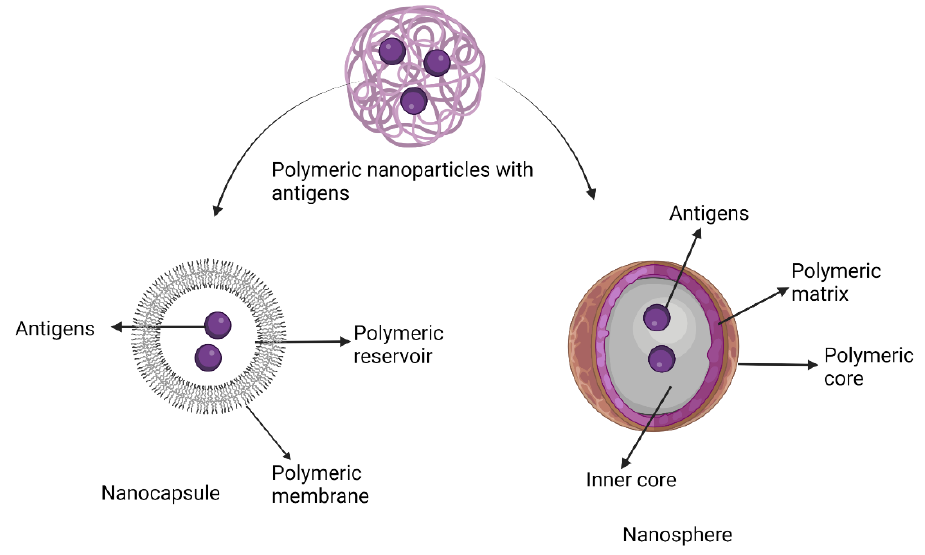
Figure 7. Schematic polymeric nanoparticles.